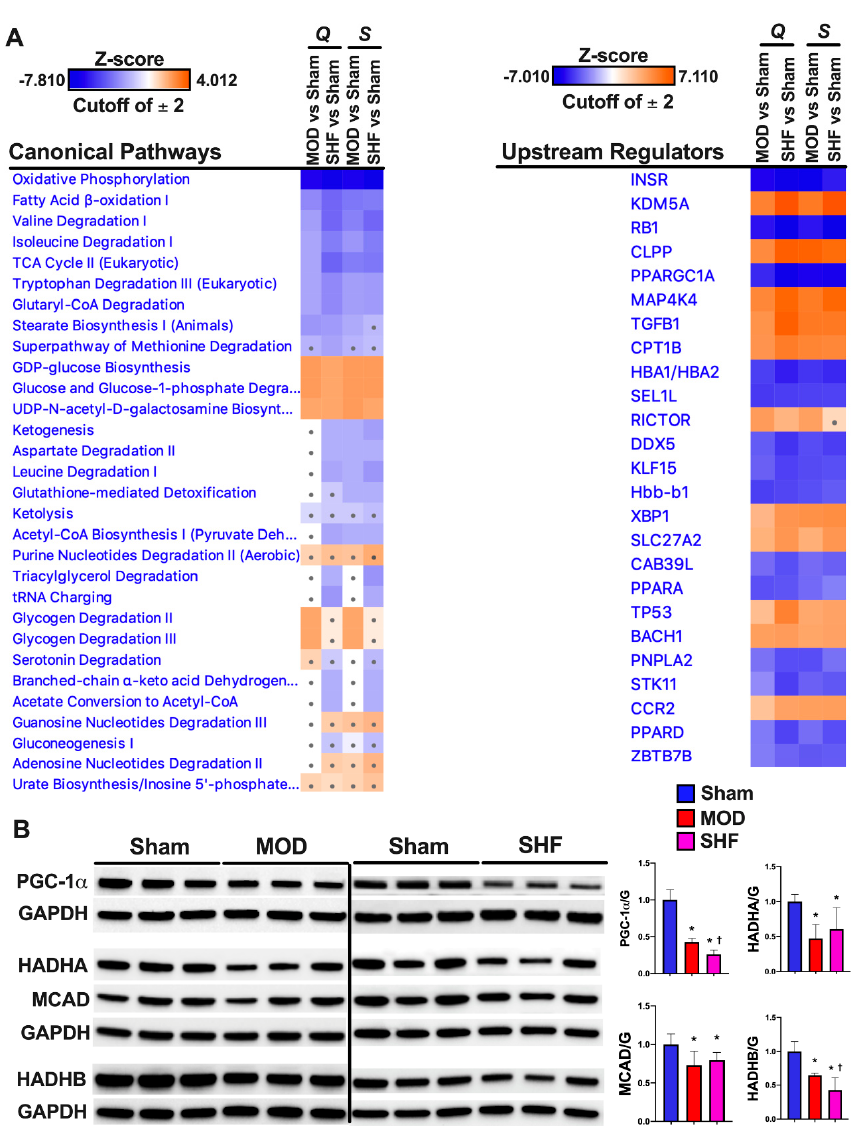
Figure 2. Top-ranked Canonical Pathways related to metabolism and Upstream Regulators , resulting from IPA’s ‘Comparison Analyses’ of the experimental groups. ( A ) ‘Core Analyses’ of the statistically analyzed proteomic datasets, by both Qlucore (Q) and Scaffold (S) bioinformatics software, were performed in IPA for each of the two-group comparisons, i.e., MOD vs. Sham and SHF vs. Sham, with a cutoff p -value < 0.05. Analyzed datasets were then subsequently compared with each other in IPA’s ‘Comparison Analyses’ function to yield the most enriched Canonical Pathways (left) related to metabolism and Upstream Regulators (right) that were shared among the two-group comparisons. The respective z-score-based heat maps indicate shared Canonical Pathways and Up- stream Regulators that were up-regulated/activated or down-regulated/inhibited in the two-group comparisons, with orange and blue color intensities representing the z-score-based extent of up-regulation/activation or down-regulation/inhibition, respectively. Canonical Pathways and Up- stream Regulators with a z-score outside the cutoff value are represented by a dot on the heat map.